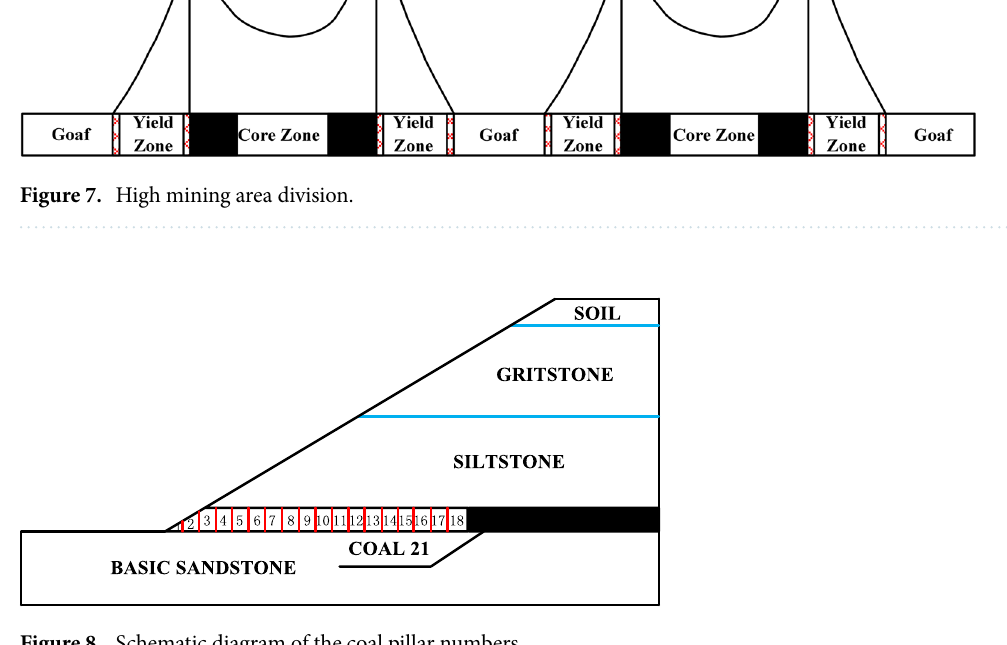
Figure 8. Schematic diagram of the coal pillar